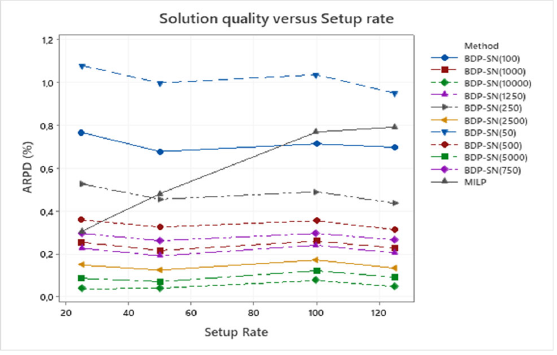
Fig. 14. ARPD variation with respect to the setup rates for the second experimental